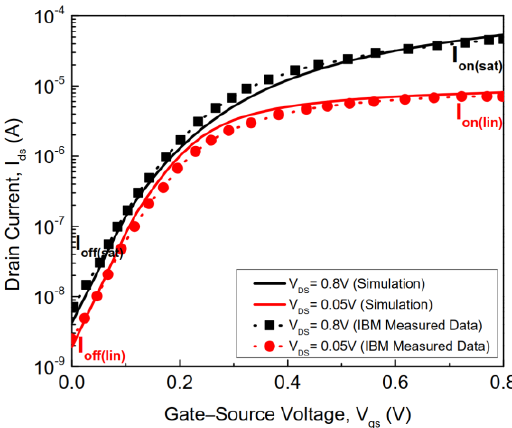
Table 2. Characteristics for the investigated FinFET model